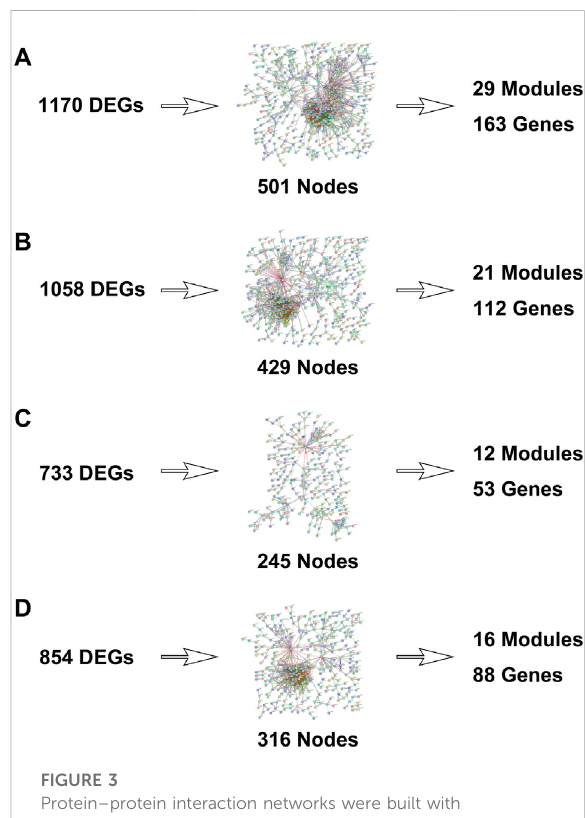
FIGURE 3 Protein – protein interaction networks were built with differentially expressed genes. [ (A) : TNBC vs. normal, (B) Her2 vs. normal, (C) luminal A vs. normal, and (D) luminal B vs.